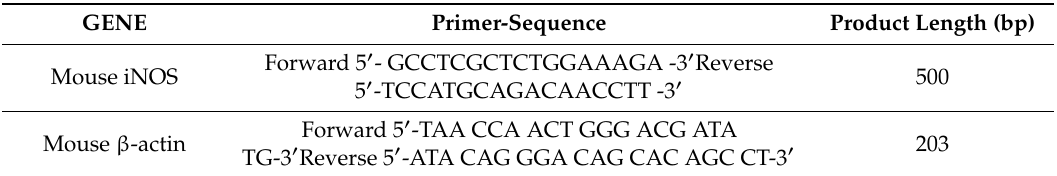
Table 1. Primers used for